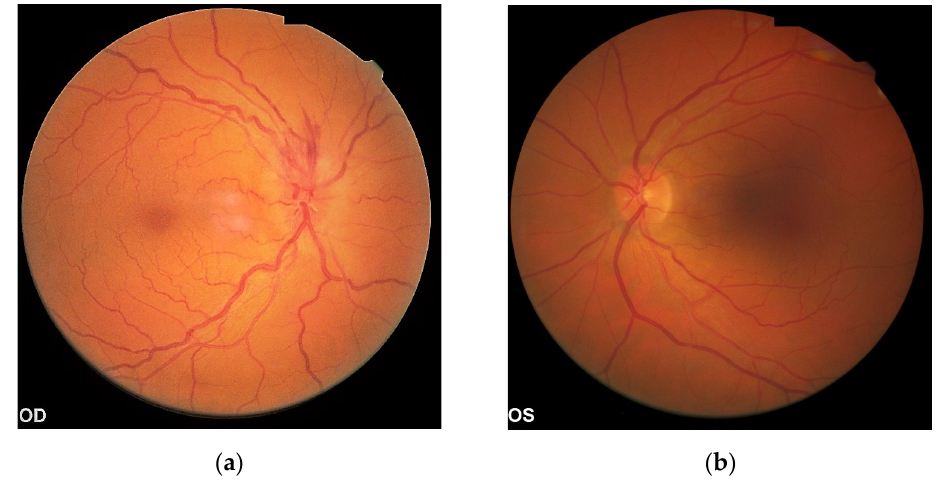
Figure 1. Fundus Examination of the right eye: ( a ) Right Eye; ( b ) Left Eye. Gonioscopy showed angle closure in both eyes, supported by the anterior segment OCT that revealed a 4 degree closed angle in the right eye and a 1 degree closed angle in the left eye (Figure 2a,b).